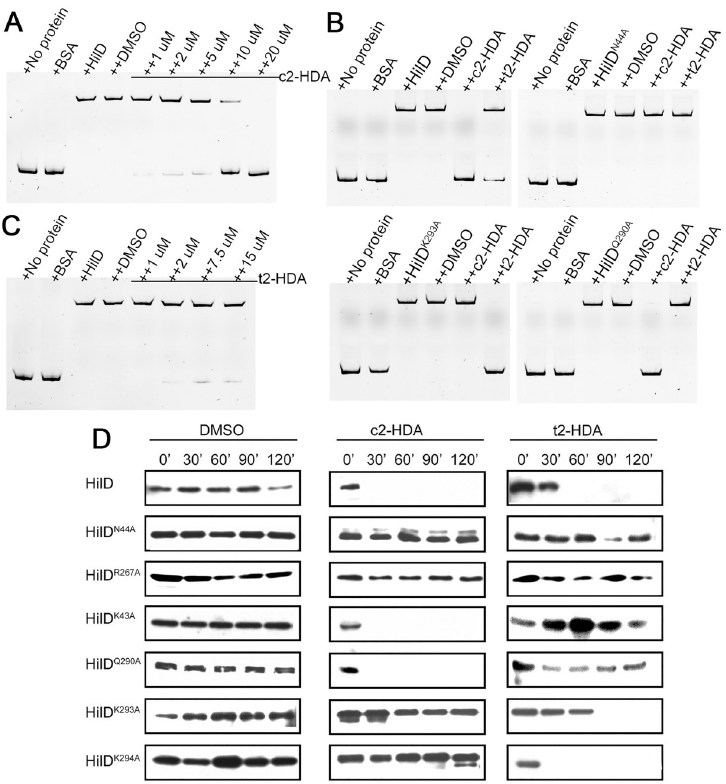
Fig 5. Binding of c2-HDA to specific HilD residues dictates its stability and capacity to bind target DNA. (A,C) EMSA of hilA promoter DNA (10 nM) in the presence of 150 μ M BSA or wild type HilD with increasing concentrations of c2-HDA (A) or t2-HDA (C). (B) EMSA of hilA promoter DNA (10 nM) in the presence of 150 μ M BSA or wild type HilD or mutant proteins with 30 μ M c2-HDA or t2-HDA. (D) Western blot of HilD degradation assay. Salmonella strains carrying wild type or mutant hilD -3XFLAG constructs were grown in the presence of 20 μ M c2-HDA or t2-HDA. Protein expression was halted and cultures were collected at indicated time points to analyze the stability of HilD by western